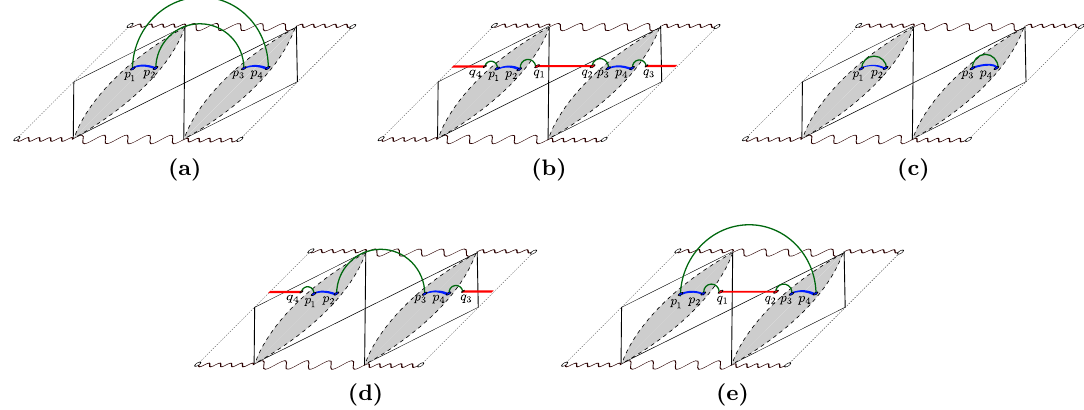
Figure 13. Configurations of the RT geodesics extending into the 3d bulk which determine the competing generalized entropy channels. The drawings are identified across the dashed line which goes through the bifurcation surface of the second black hole. Multiple-island configurations that are always subleading are not